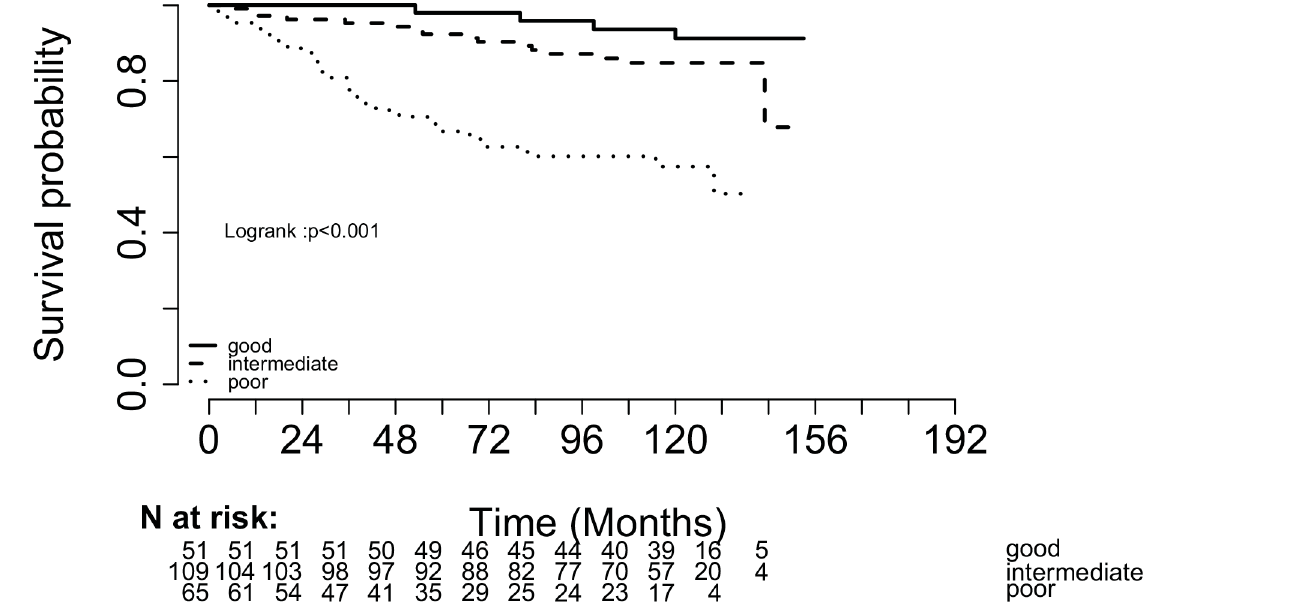
Fig 1. Breast Cancer Specific Survival according to the Nottingham Prognosis